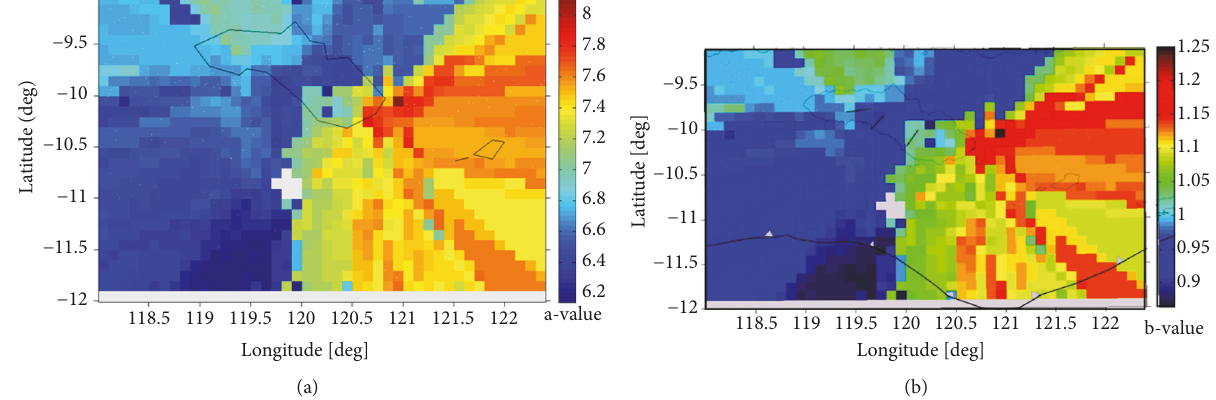
Figure 14: Spatial variation of seismicity of cluster 3 (Sumba island and surrounding areas): (a) a-value and (b)